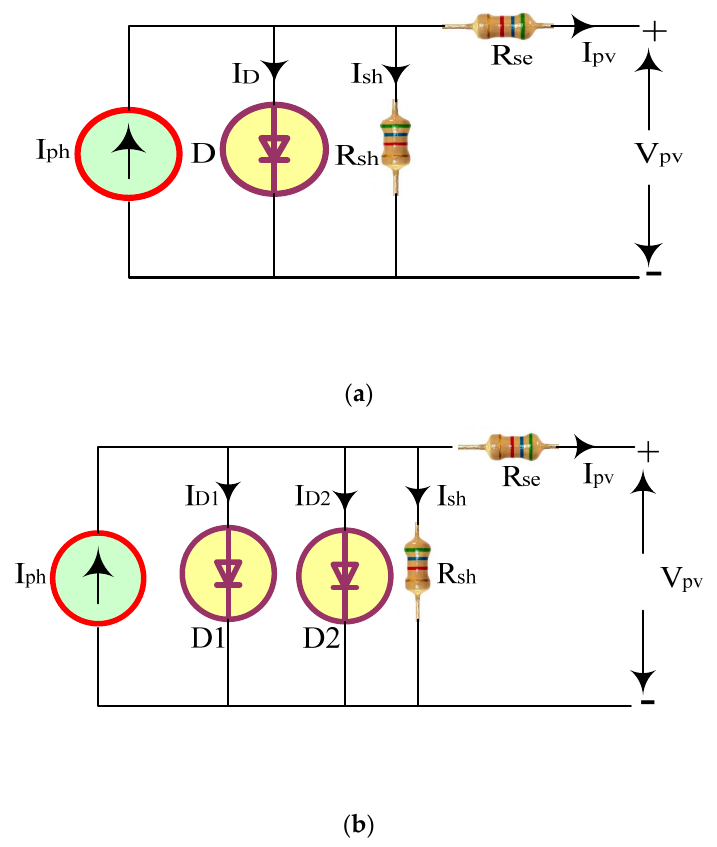
Figure 2. Solar cell: ( a ) single-diode model and ( b ) double-diode model. The current generated by the solar cell can be computed by Equation (1).